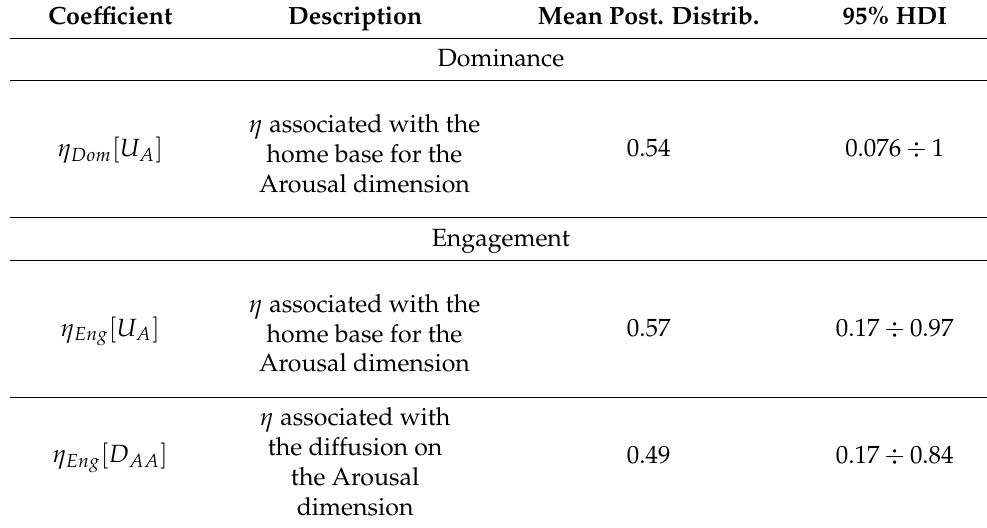
Table 3. Causal Bayesian Linear Regression model coefficients not containing zero value in the HDI of the posterior.